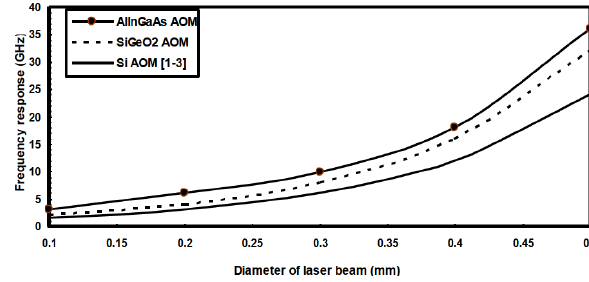
Figure 4: Variations in modulation frequency in relation to laser beam diameter for the previous and proposed AOMs at room tem-